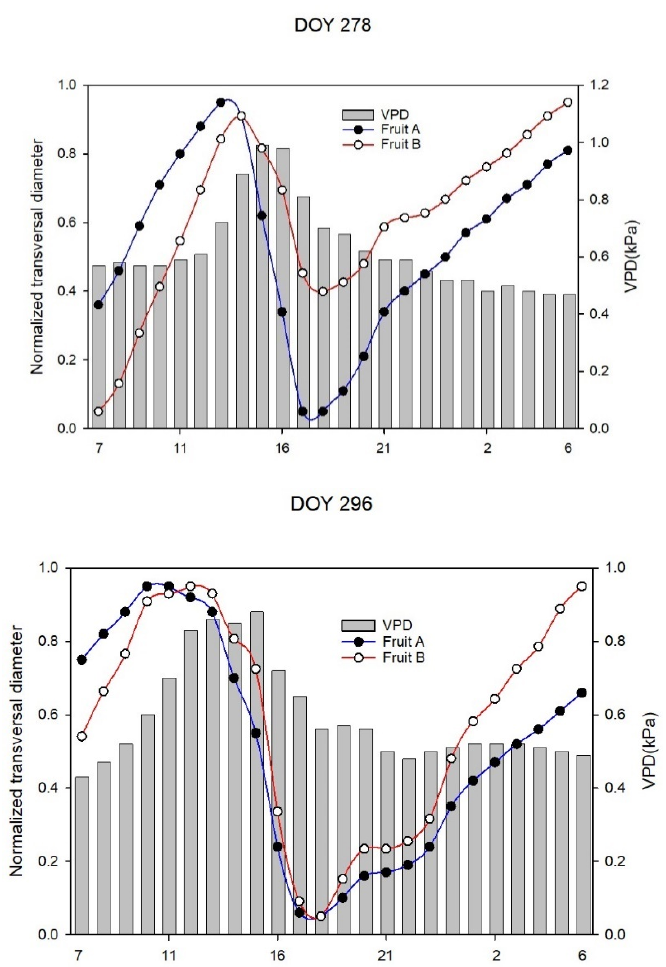
Figure 5. Continuous measurements of transversal diameter of fruit A and fruit B at example days of the second period of the experiment.